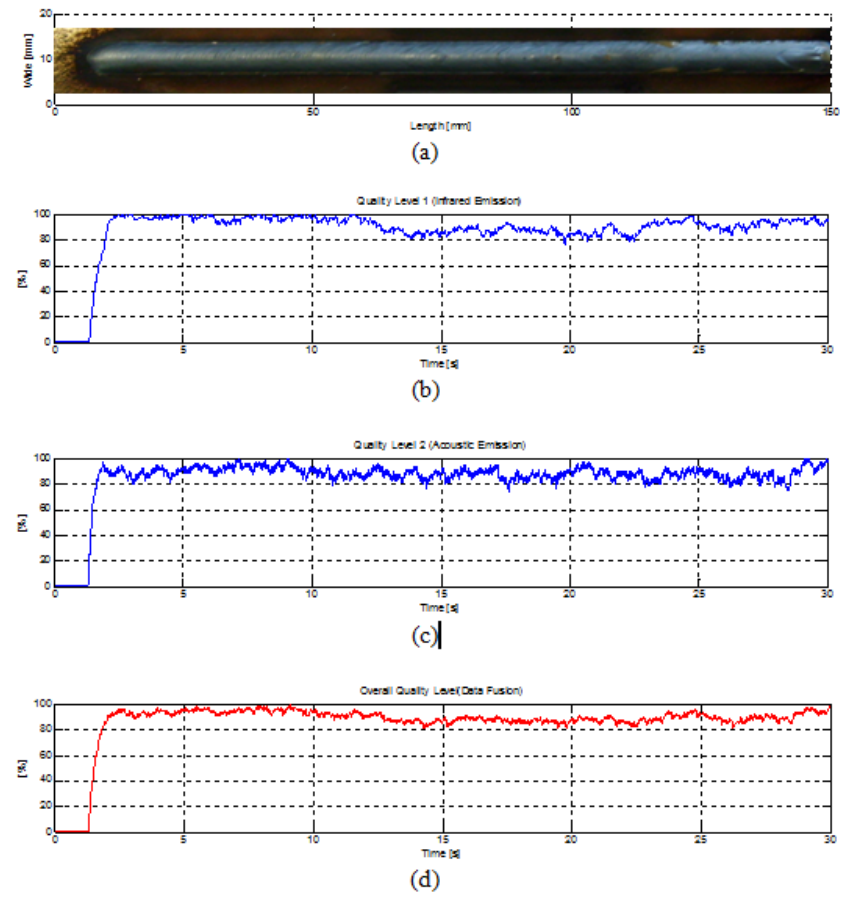
Figure 9. Quality level parameters, ( a ) welding trial with induced perturbation, ( b ) From infrared signal, ( c ) From acoustical signal, ( d ) overall quality measured based on data